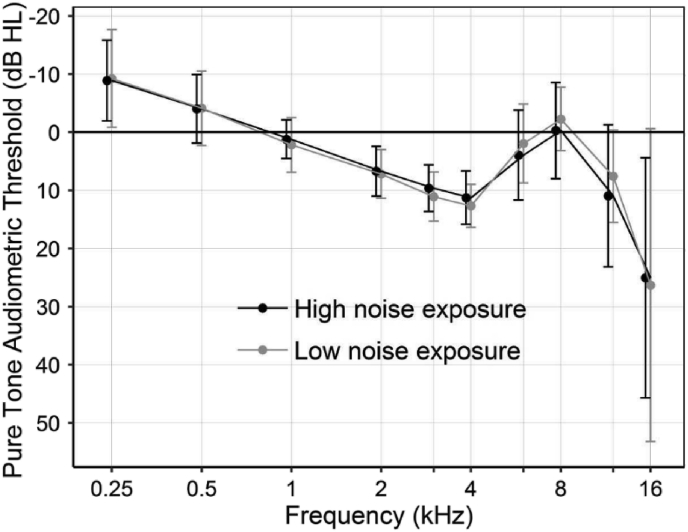
Audiometric threshold (lines denote means and error bars denote standard deviations) over 250 Hz to 16 kHz for low and high exposure groups. Thresholds ≤20 dB HL over the range 500 Hz to 8 kHz were amongst the eligibility criteria for inclusion in the study. 4/60 [low noise exposure group] and 7/64 [high noise exposure group] participants were not measured at 16 kHz as their audiometric thresholds were >90 dB HL (greater than the output level of the audiometer) and as such their 16 kHz values were recorded as 90 dB HL.